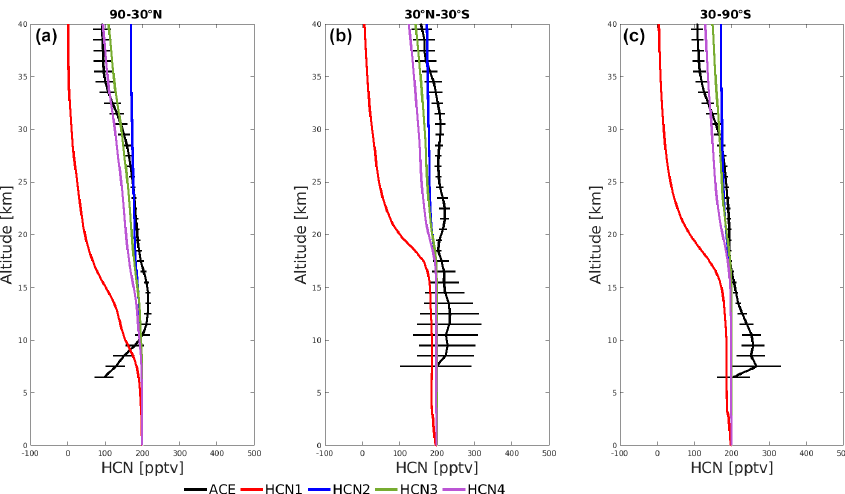
Figure 3. Average HCN profiles for March–May 2009 for four TOMCAT model tracers (HCN1–HCN4) compared with the profiles measured by ACE-FTS with ± 1 median absolute deviation for latitude bands 90–30 ◦ N (a) , 30 ◦ N–30 ◦ S (b) , and 30–90 ◦ S (c) . See Table 2 for details of the photochemical loss reactions included in the different model HCN